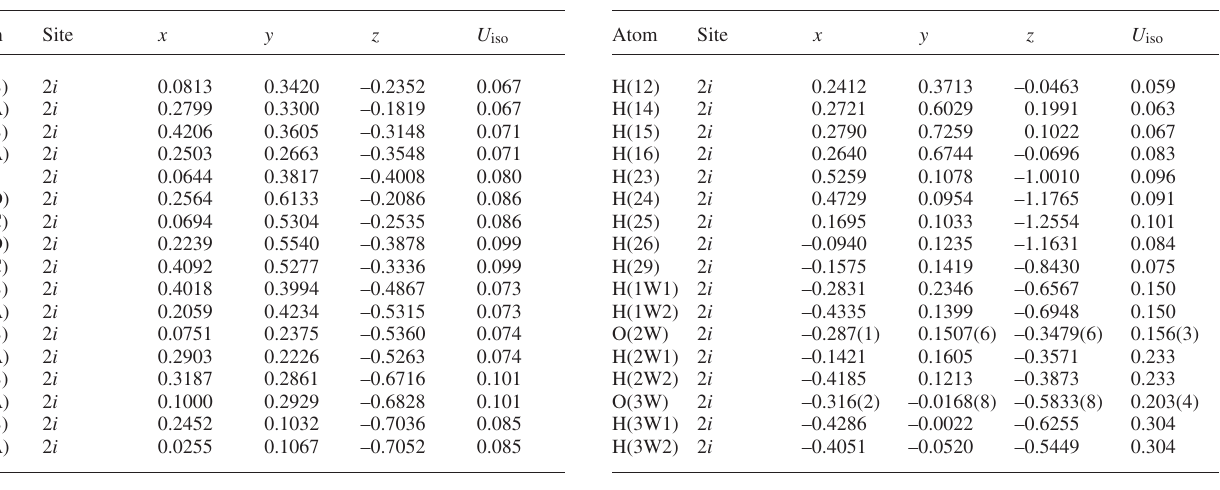
Table 2. Atomic coordinates and displacement parameters (in Å 2 )